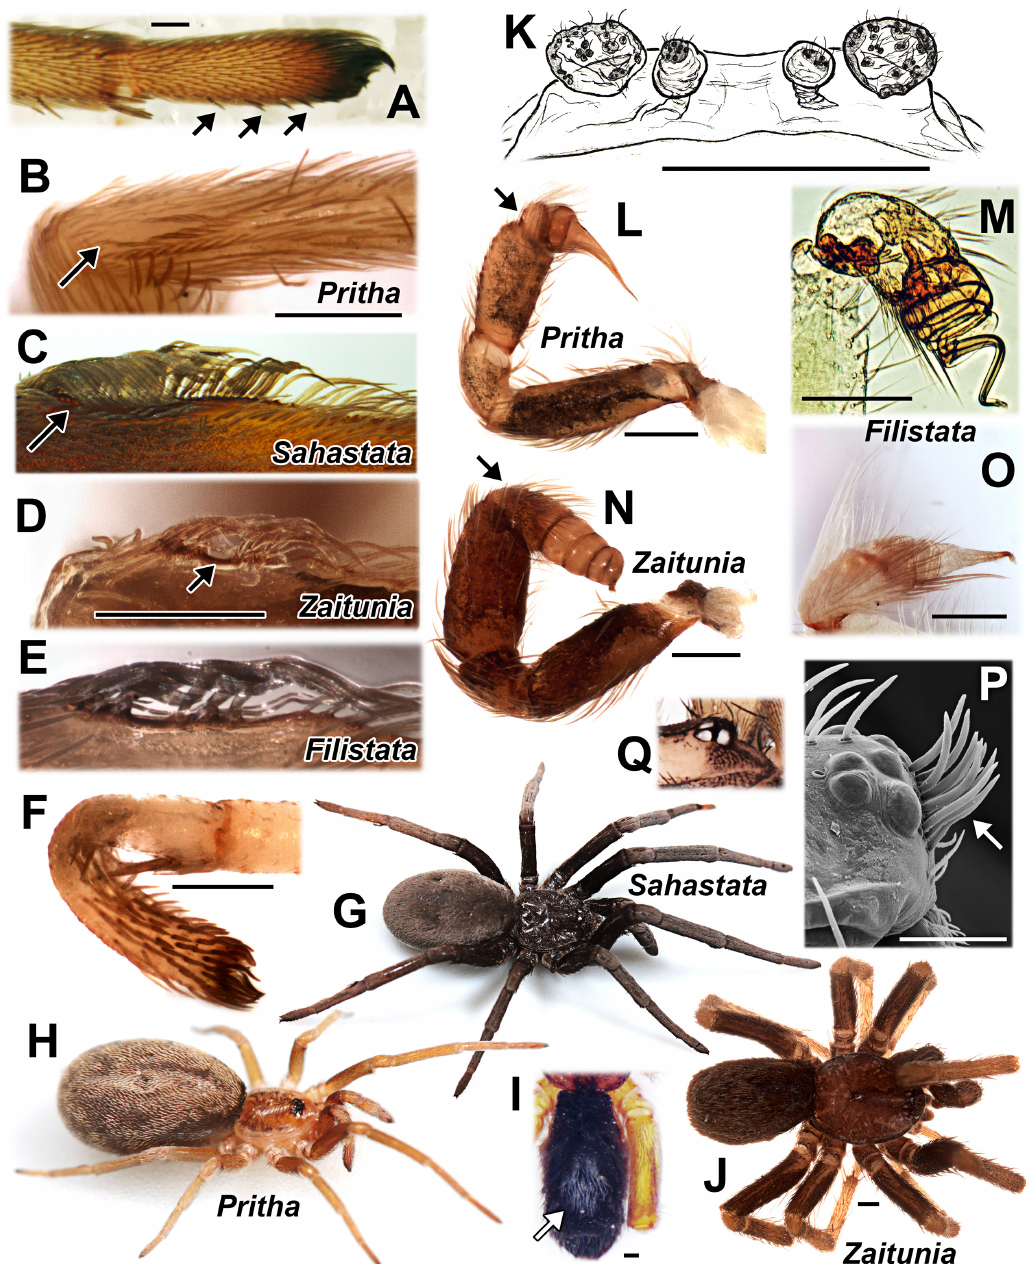
Fig. 10. Filistatid morphology. A . Filistata insidiatrix (Forsskål, 1775), ♀, leg tarsus, arrow points to macrosetae. B . Pritha nana (Simon, 1968), arrow points to right calamistrum. C . Sahastata aravaensis Ganem et al. , 2022, left calamistrum. D . Zaitunia schmitzi Kulczyński, 1911, left calamistrum, arrow points to gap between setae. E . Filistata insidiatrix , left calamistrum. F . Filistata lubinae Zonstein & Marusik, 2019, ♂, tarsus I. G . Sahastata aravaensis , ♀. H . Pritha IFMsp185, ♀. I . Pritha sp., male abdomen, dorsal view. J . Zaitunia schmitzi , ♂. K . Zaitunia schmitzi , spermathecae ventral view. L . Pritha tenuispina (Strand, 1914), ♂, left pedipalp, prolateral view, arrow points to cymbium. M . Filistata lubinae , left copulatory bulb, prolateral view. N . Zaitunia schmitzi , ♂, left pedipalp, prolateral view, arrow points to cymbium. O . Filistata albens Zonstein & Marusik, 2019, left copulatory bulb, prolateral view. P . Zaitunia schmitzi , male clypeus, lateral view, arrow points to stout setae. Q . Filistata insidiatrix , female clypeus, lateral view. Scale bars = 0.2 mm.